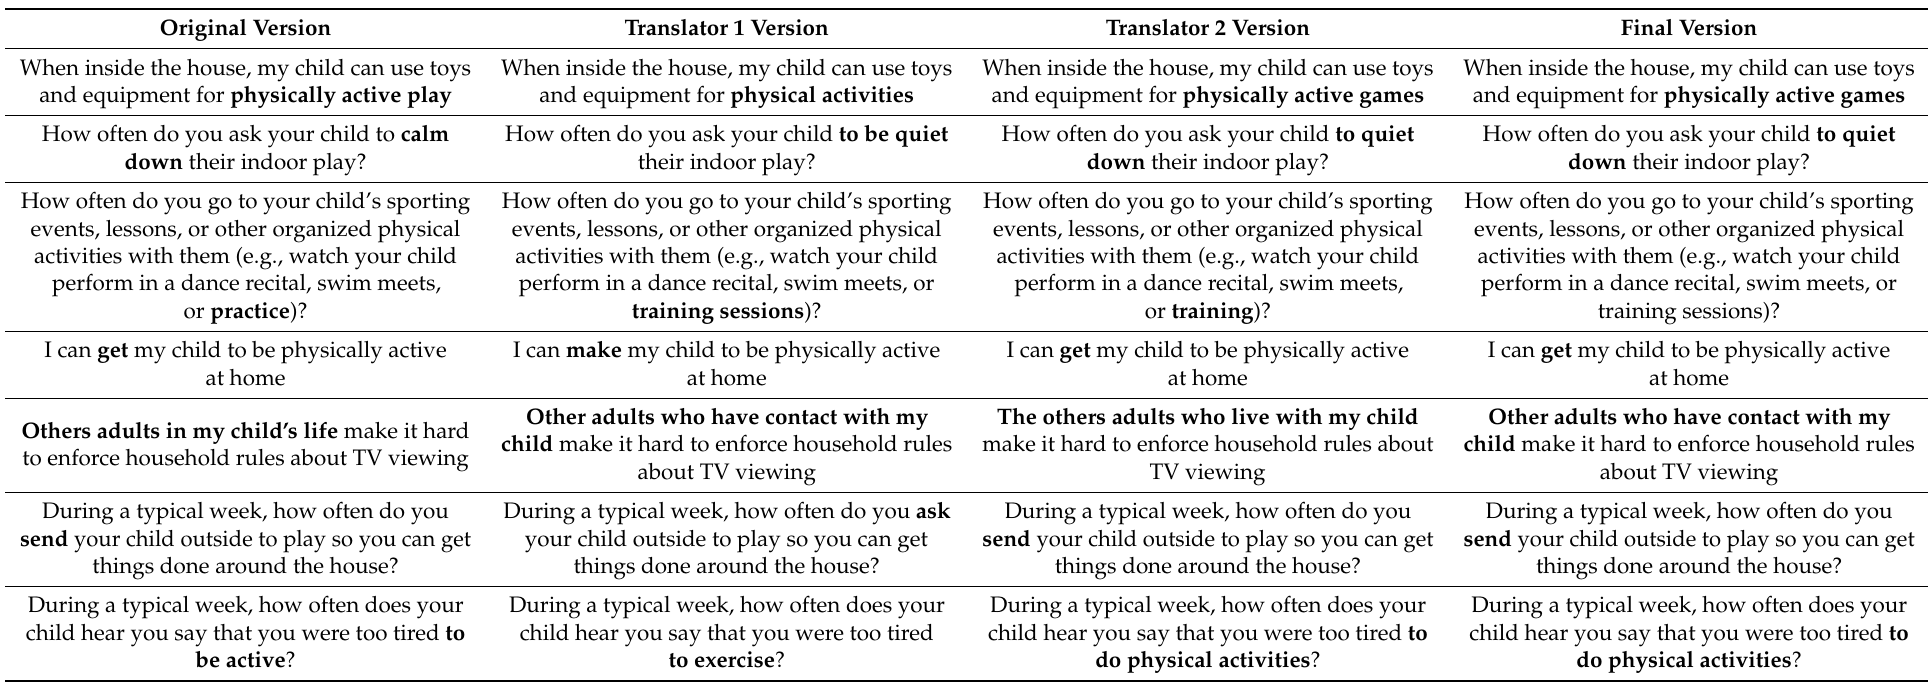
Table 3. Discrepancies in the back-translated version of the measurement